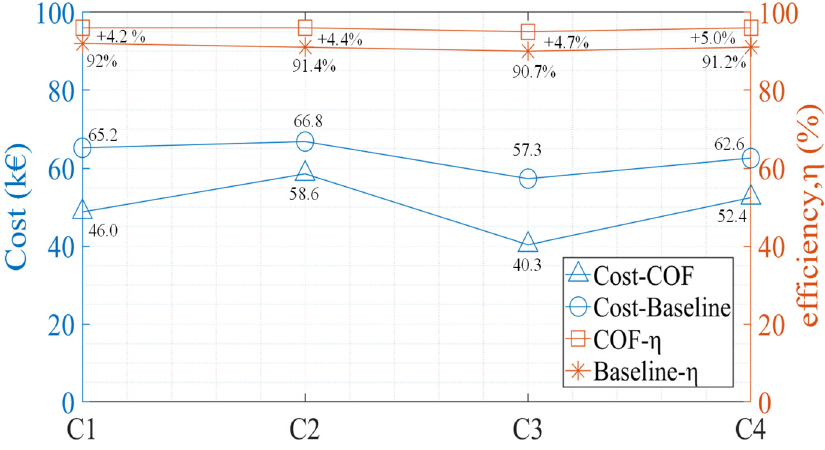
Figure 12. Comparison of the obtained optimal sizing from COF and baseline for HBESS solutions.